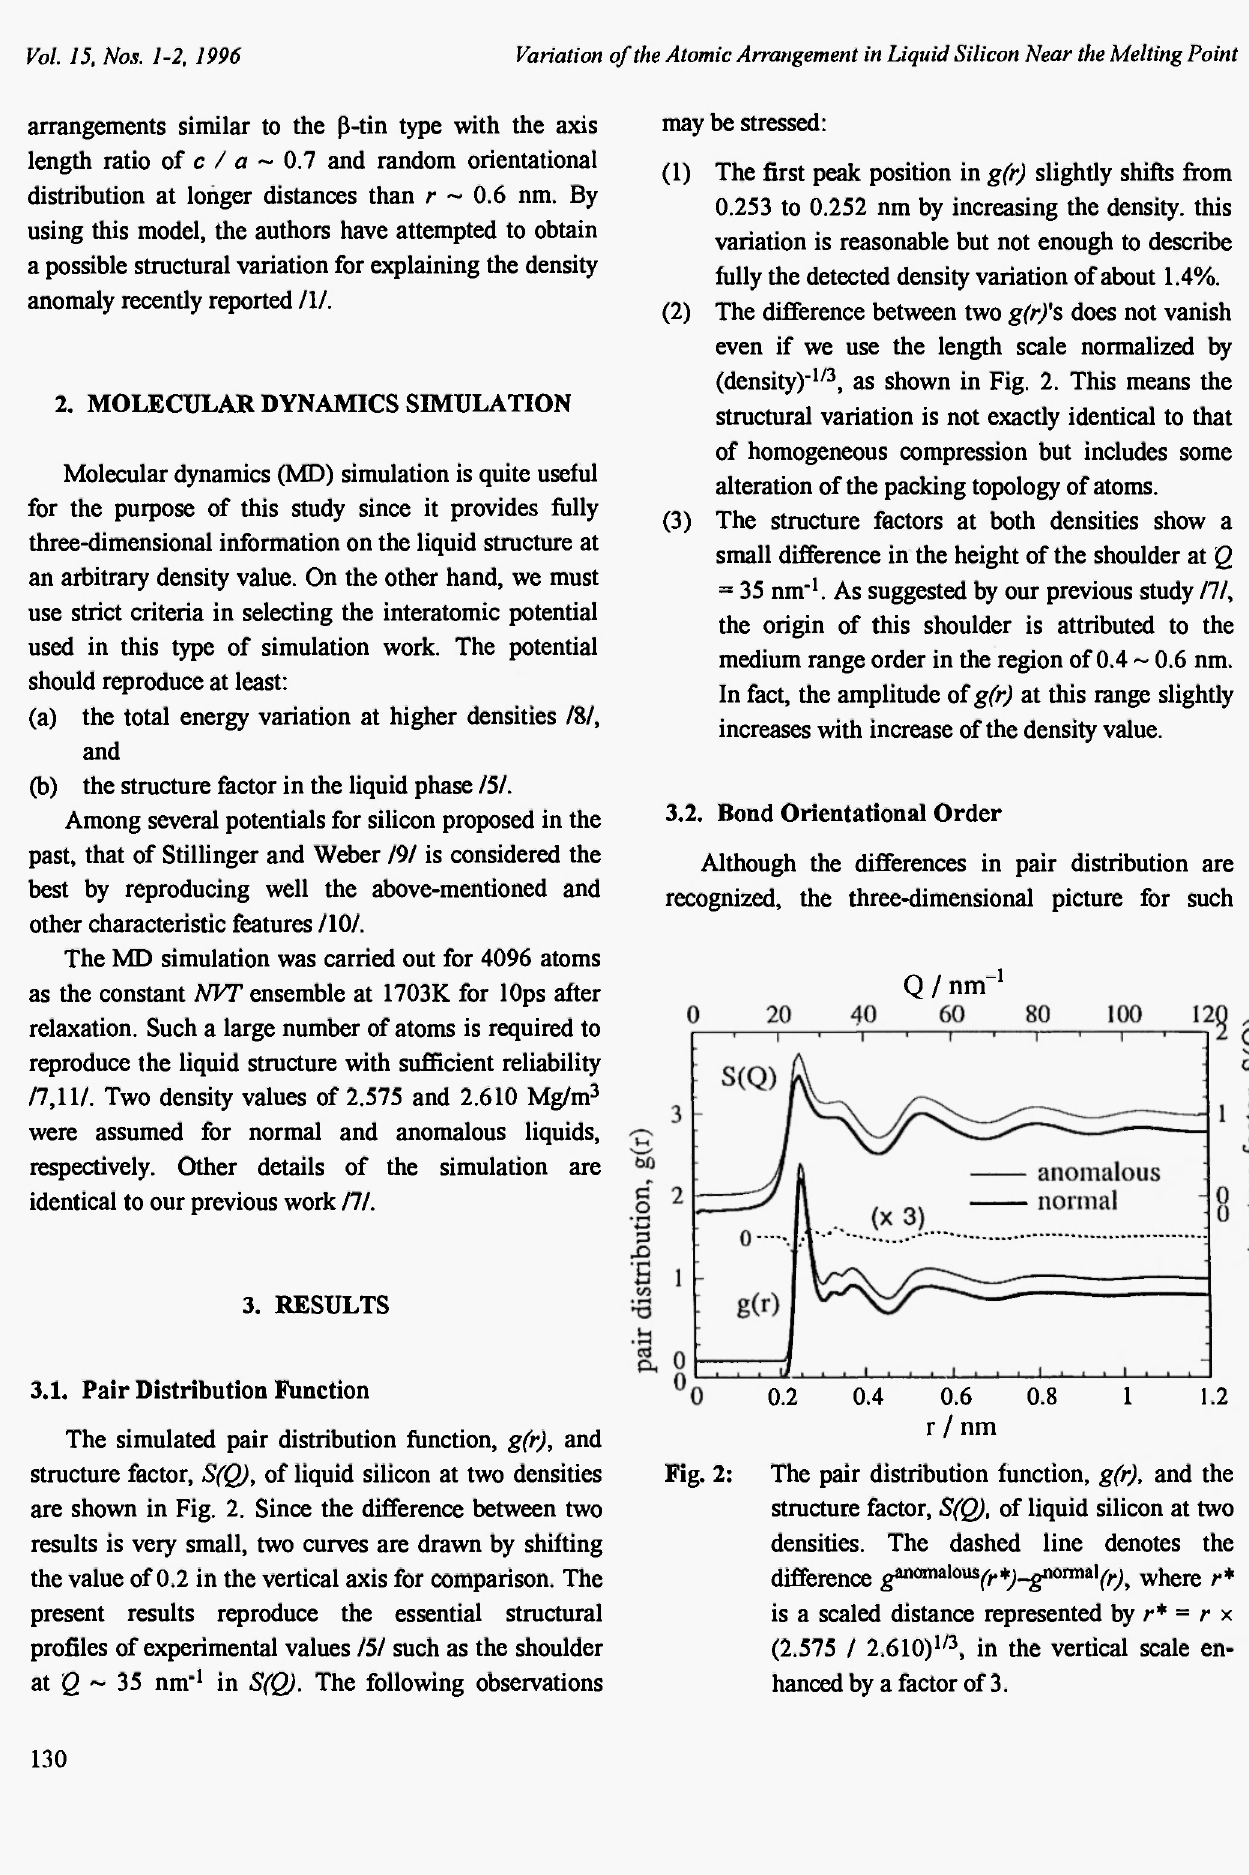
Fig. 2: The pair distribution function, g(r), and the structure factor, S(Q), of liquid silicon at two densities. The dashed line denotes the difference ganomaiouy *j_g norma Y^ here r* r ) W is a scaled distance represented by r* = r χ (2.575 / 2.610) 1/3 , in the vertical scale en- hanced by a factor of